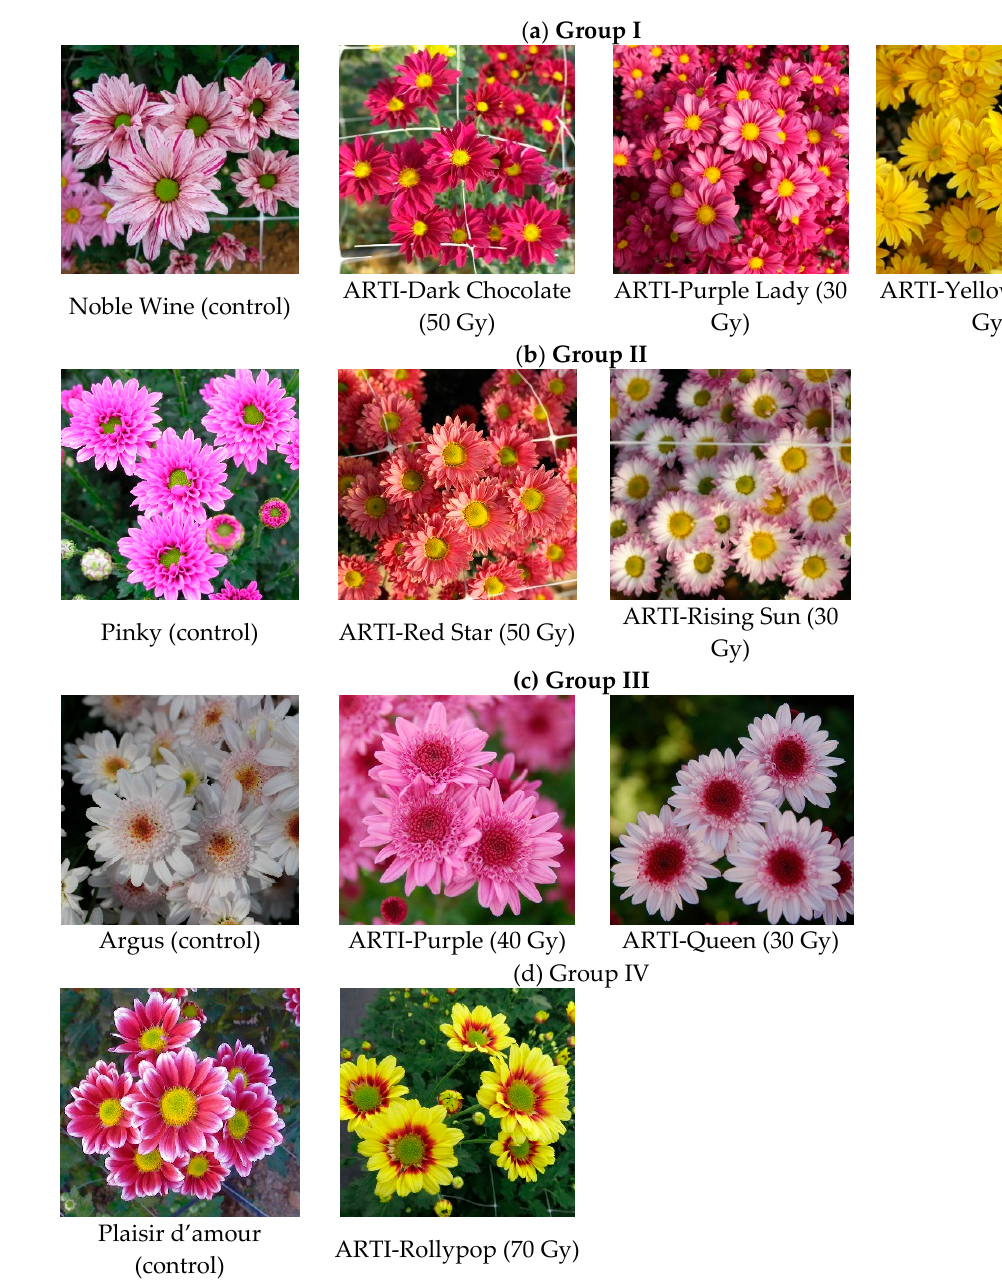
Figure 1. Twelve Chrysanthemum morifolium cultivars. ( a ) Group I: the mutant cultivars ‘ARTI-Purple Lady’ (30 Gy), ‘ARTI-Yellow Star’ (50 Gy), ‘ARTI-Dark Chocolate’ (50 Gy) derived from the original cultivar ‘Noble Wine’; ( b ) Group II: the mutant cultivars ‘ARTI-Red Star’ (50 Gy) and ‘ARTI-Rising Sun’ (30 Gy) derived from the original cultivar ‘Pinky’; ( c ) Group III: the mutant cultivars ‘ARTI-Purple’ (40 Gy) and ‘ARTI-Queen’ (30 Gy) derived from the original cultivar ‘Argus’; ( d ) Group IV: the mutant cultivars ‘ARTI-Rollypop’ (70 Gy) from the original cultivar ‘Plaisir d’amour’.